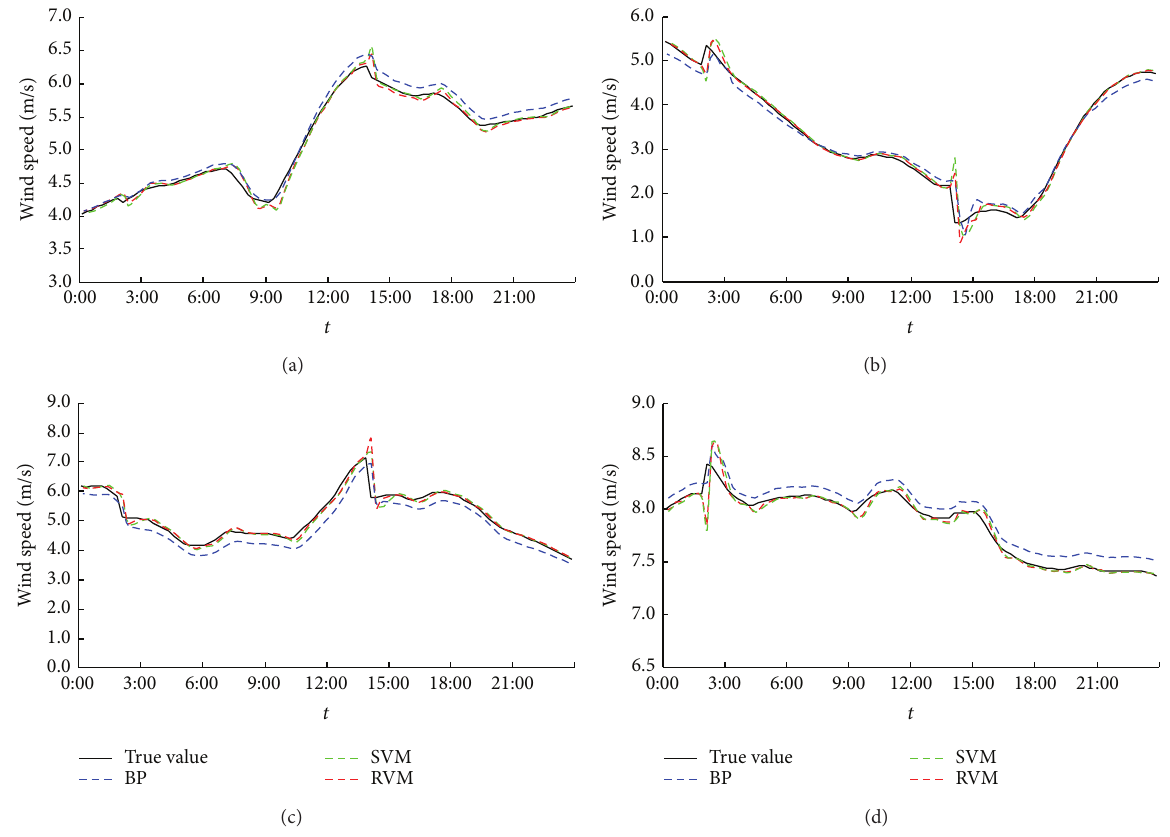
Figure 1: Forecasting results with different models on March 25 (a), June 26 (b), September 29 (c), and December 28 (d).